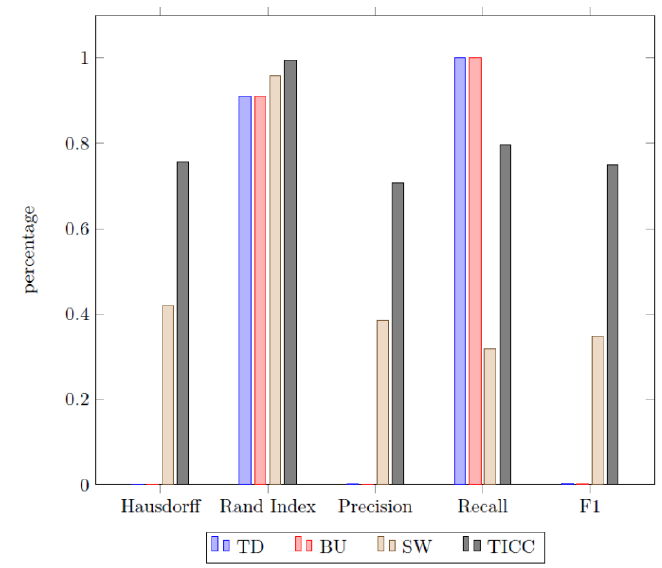
Figure 12. Comparison of segmentation approaches.